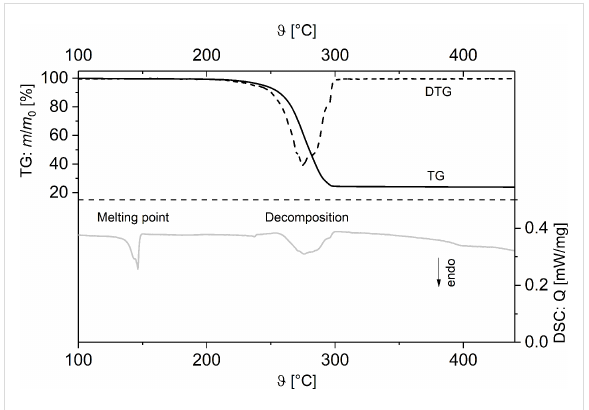
Figure 4: TG/DTG (top) and DSC (bottom) traces of 2 (Ar, gas flow 60 mL min − 1 , heating rate 5 °C min − 1 ).